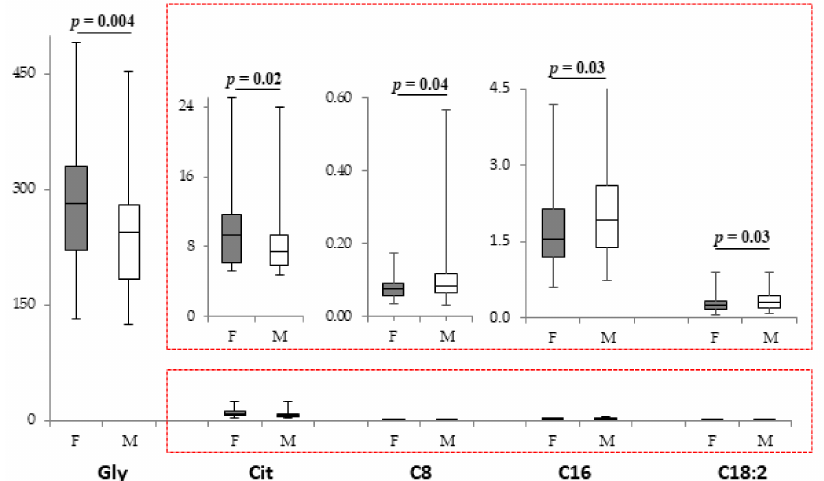
Figure 2. Box plot of metabolites ( µ M) that displays the sex difference in female ( n = 62; grey bars) and male ( n = 79; white bars) infants not fed with PN. The horizontal line across the box represents the median, and the box comprises the first and the third quartiles. The vertical lines represent the minimum and the maximum values. Red boxes represent an enlargement of the box plots necessary due to the different scale on the y